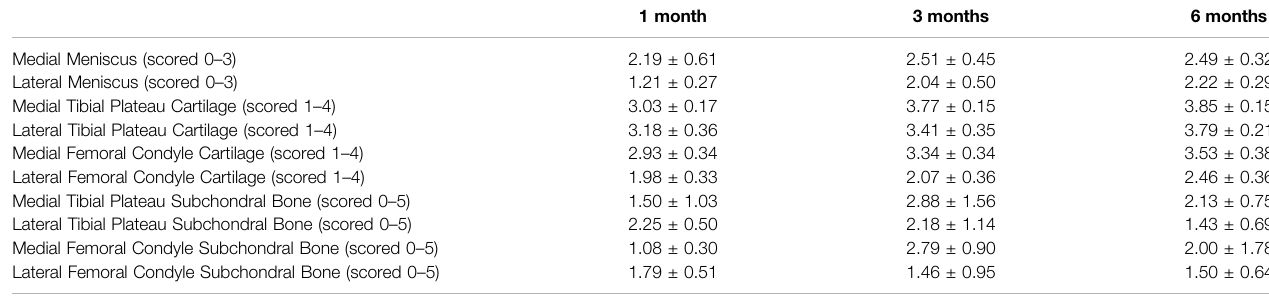
TABLE 1 | Average morphological scores for all tissues studied.